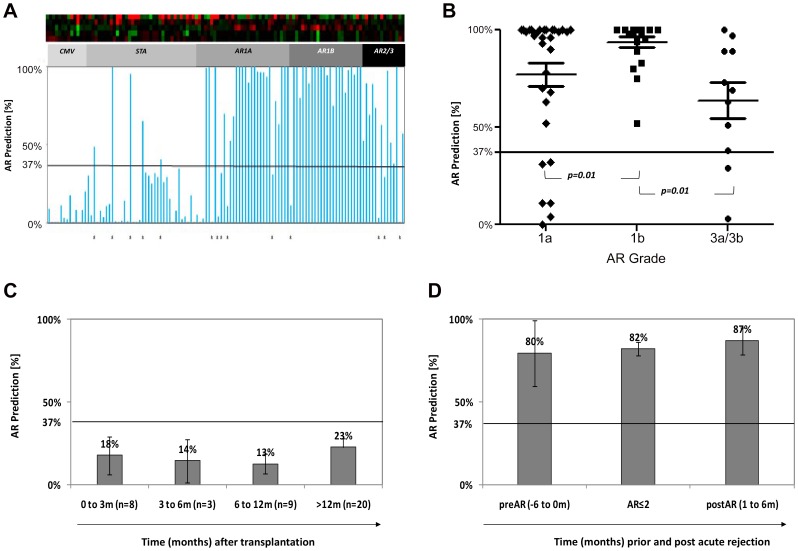
Predicted Probability of AR in 141 Peripheral Blood samples from Adult Heart Transplant Recipients.
A. The predicted probability of a sample having a non-invasive diagnosis of AR, based on the logistic regression score on the 5-gene model is shown on the Y Axis (score range 0–100%). A score>37%, from the model, classifies a sample as AR, a score <37% from the model classifies a sample as non-AR. The score is shown on all 141 samples, inclusive of the training (n = 32; 11 Grade 3 AR, 21 STA) and the test set samples (12 CMV, 19 STA, 31 AR-Grade 1a, 22 AR-Grade 1b, 2 AR Grade 2). The clinical sample phenotype is based on the matched biopsy histology read. The misclassified samples from the histology read and the blood gene-model read are marked by asteryx. B. The Individual and group predicted probabilities for all 66 AR samples. The blood-gene model classifies all AR-Grade 1b correctly (a significant finding with p = 0.01, for classification of other AR grades). C. The predicted probabilities for AR for all Stable samples without any evidence of acute rejection (STA), with sampling times at different times post-transplantation. D. The predicted probabilities for AR for all 55 untreated AR samples (AR-Grades≤2), where no treatment intensification was given for the diagnosis of AR. Serial samples from these patients collected within 1–6 months prior (n = 11), or within 1–6 months after (n = 12), these AR episodes. The gene-model predicts AR prior to biopsy diagnosis and remains elevated in most samples without immunosuppression intensification.